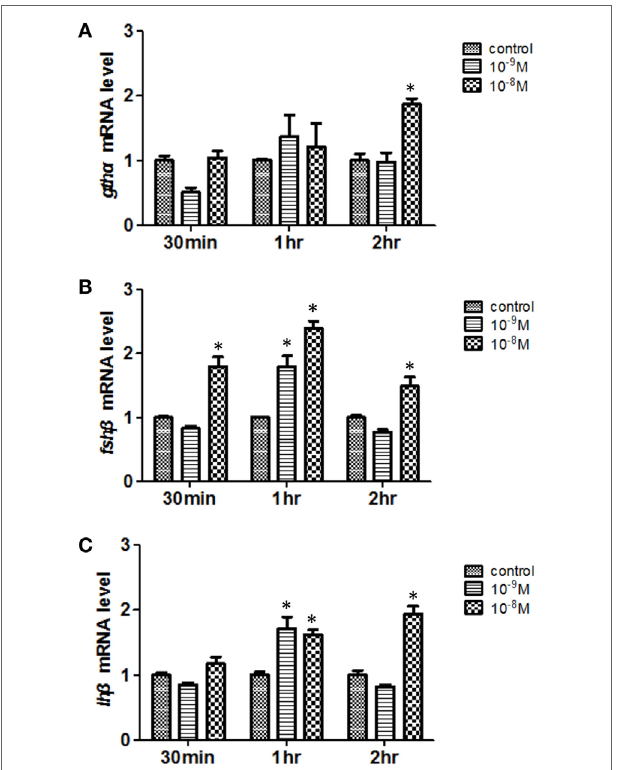
FigUre 5 | Effects of Leptin on (a) gth α , (B) fsh β , and (c) lh β expression in 5-month-old female non-transgenic carp pituitary cells in vitro. Pituitary cells were exposed to Leptin for 30 min, 1, and 2 h. The expression of the target genes (mean ± SEM) were determined by real-time PCR and were expressed as fold change normalized to the controls. The results obtained were analyzed by independent sample t -test compared with controls. Asterisks indicate statistically significant differences at P <